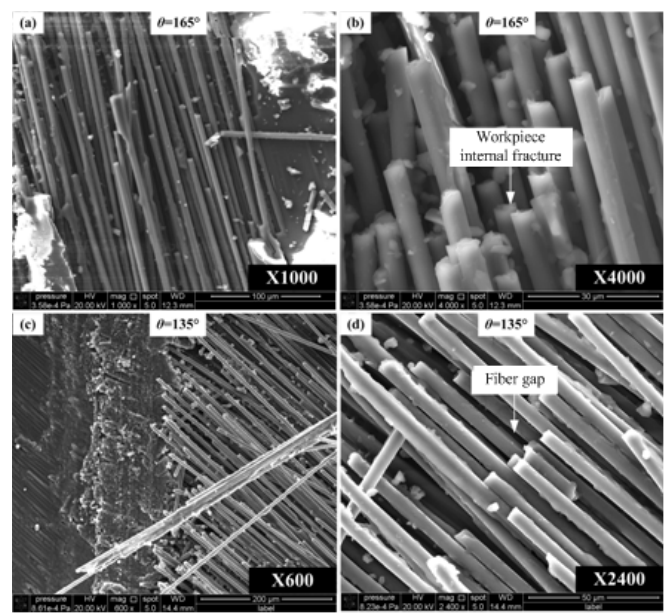
Figure 14. Fracture topography SEM photos of carbon fiber with orientation angles inverse fiber direction. ( a ) 165° orientation angle with 1000X magnification; ( b ) 165° orientation angle with 4000X magnification; ( c ) 135° orientation angle with 600X magnification; ( d ) 135° orientation angle with 2400X magnification.